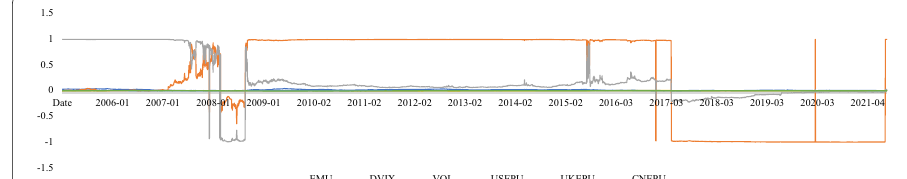
0.150.20.250.30.350.4 -0.1-0.0500.050.1 Fig. 4 Time-varying loadings of the PLS factors ( W = 1000 )